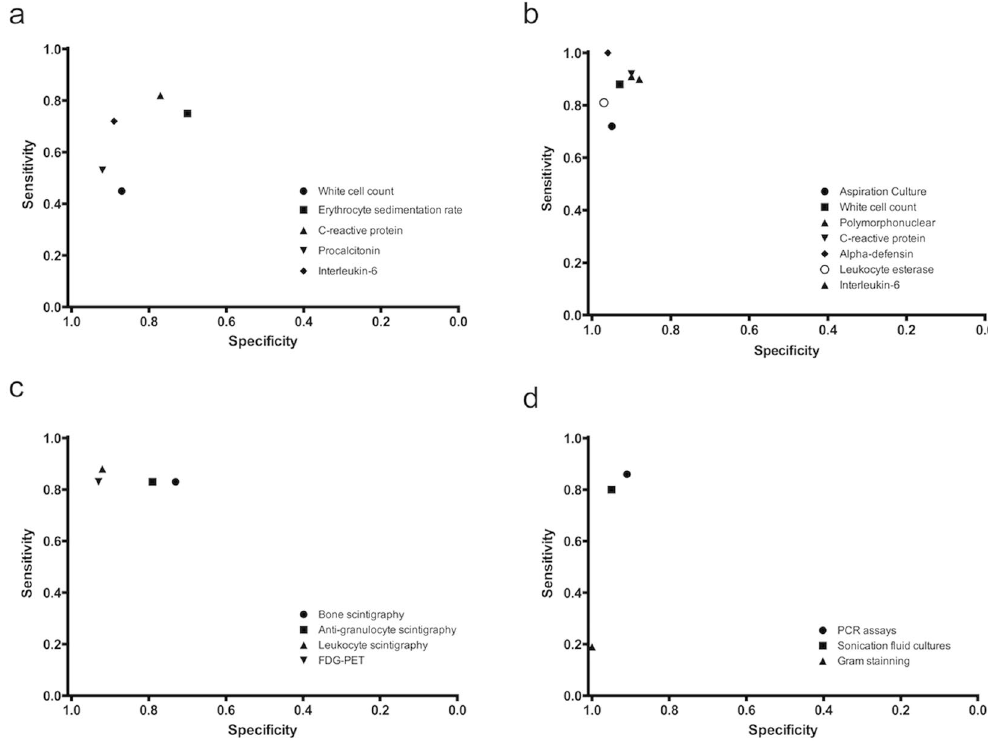
Figure 5. Scatter diagrams for the diagnostic accuracy of the IL-6 test, as assessed by the meta-analysis: serum biomarkers ( a ); synovial fluid biomarkers and aspiration culture ( b ); nuclear medicine ( c ); and tests with biopsy ( d